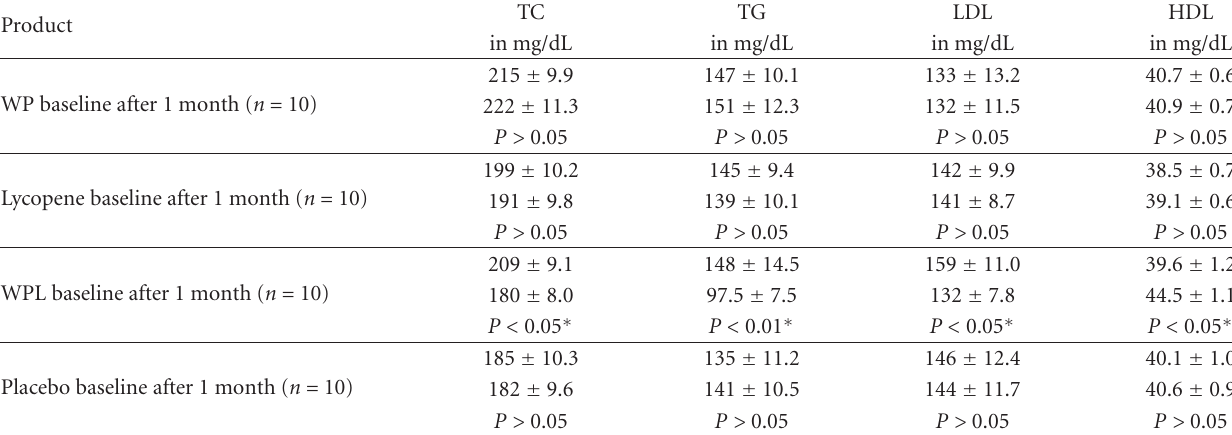
Table 2: Changes in lipid profile in prehypertensive patients treated with whey protein and lycopene